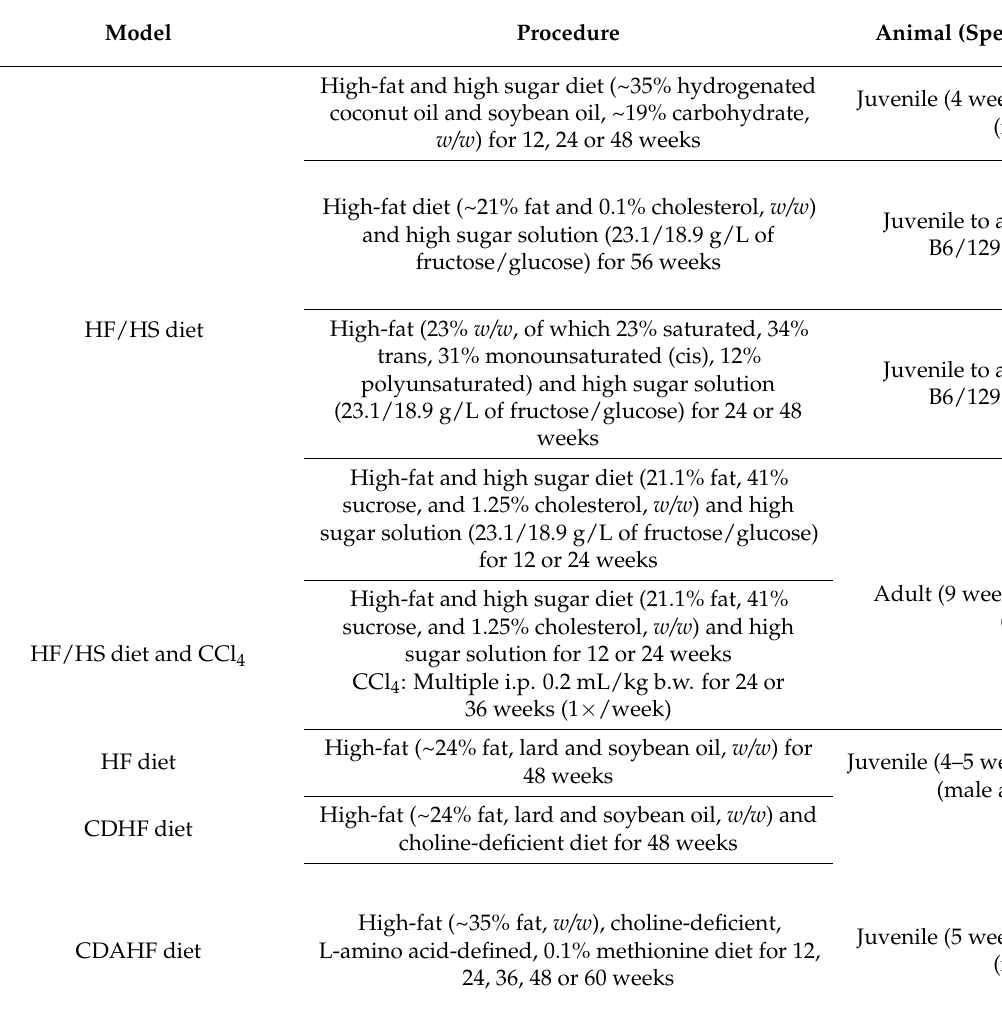
Table 3. Summary of some of the NASH-induced hepatocarcinogenesis protocols